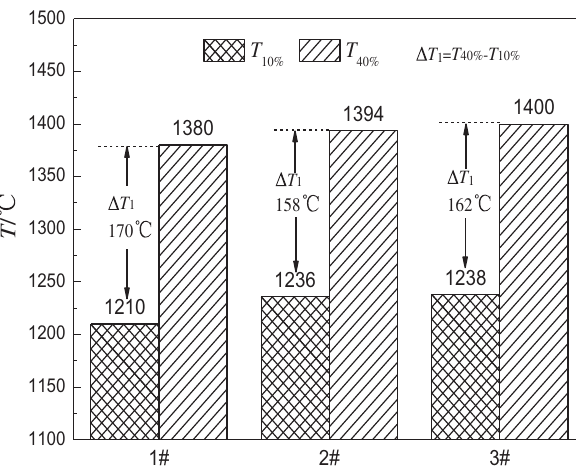
Figure 2: T 10% and T 40% with different w (Cl -